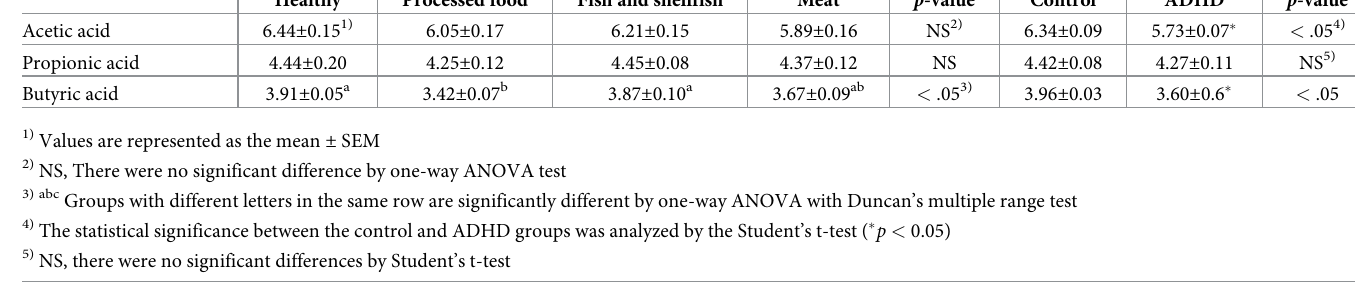
Table 6. Concentrations of short-chain fatty acids in the feces of Korean elementary school students according to their dietary patterns and ADHD scores. Fatty acids (mmol/g)